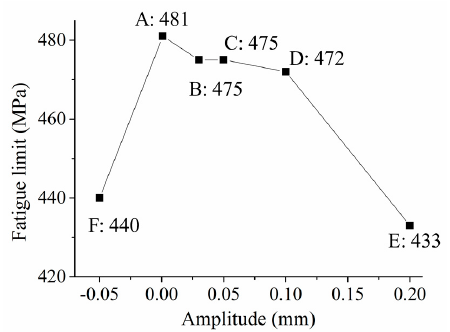
Figure 10. Fatigue limits under di ff erent amplitudes ( − 0.05 mm amplitude stands for the annealing treatment).